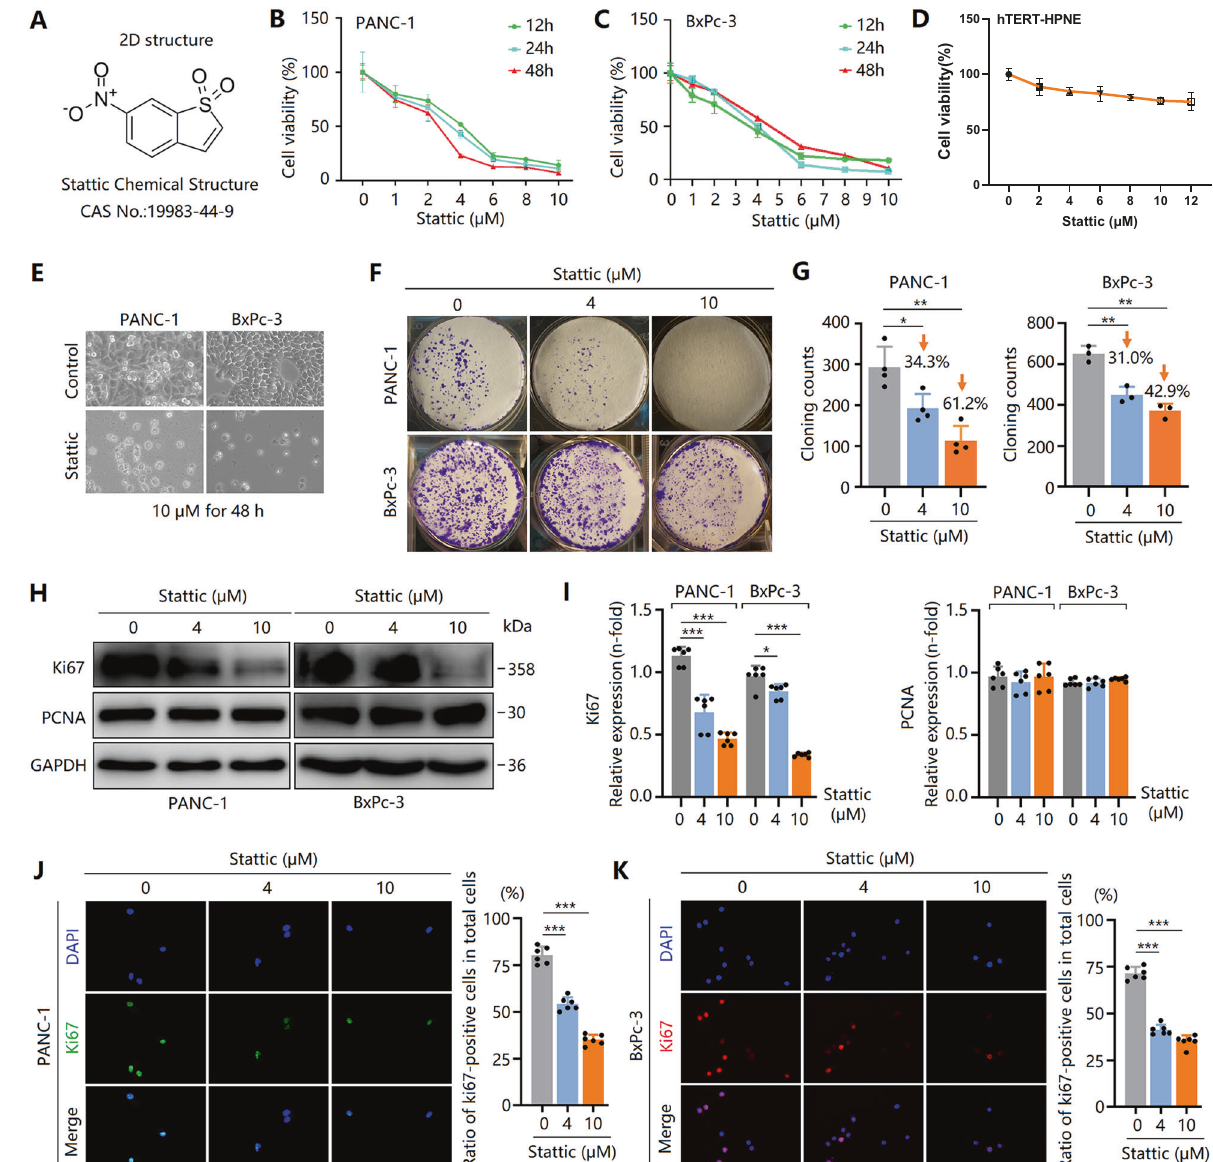
Fig. 1 Stattic time- and dose-dependently inhibits proliferation of PCCs. PCCs were treated with various concentrations of Stattic for 24 h or 48 h. A Chemical structure of Stattic. B – D Viability of PANC-1, BxPc-3, and hTERT-HPNE cells with or without Stattic treatment (0 – 12 μ M) analyzed by CCK-8 assay. E Morphology of PANC-1 and BxPc-3 cells treated with 10 μ M Stattic for 48 h. F , G The proliferation of PANC-1 and BxPc-3 cells with or without Stattic analyzed by colony formation assay. H , I Expression of PCNA and Ki67 in Stattic-treated BxPc-3 and PANC-1 cells. J , K Immunocytochemical staining of Ki67 in Stattic-treated BxPc-3 and PANC-1 cells. Bar = 50 μ m. * P < 0.05, ** P < 0.01, *** P < 0.001. activity of JAK2/STAT3 signaling was also evaluated to explore the underlying mechanism of Stattic. Our fi ndings identi fi ed an anti- tumor activity of Stattic by suppressing STAT3 Y705 phosphoryla- tion, indicating its potential of Stattic as an intervention for PC.